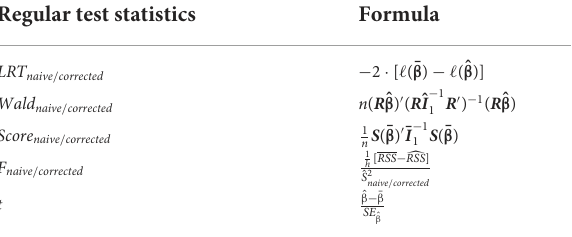
TABLE 1 Overview of all presented regular test statistics. Regular test